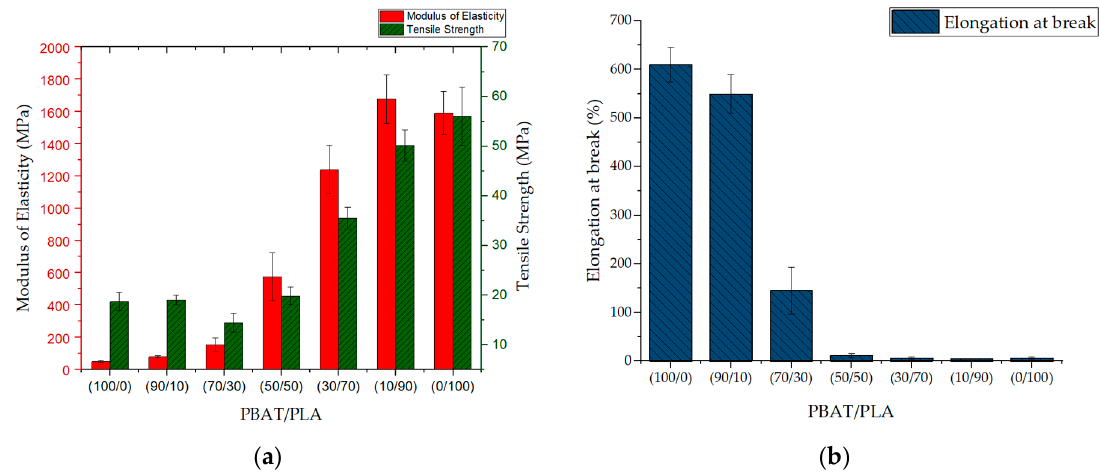
Figure 8. Tensile properties of pressed panels made of PBAT / PLA blends, pure PBAT and PLA. ( a ) modulus of elasticity and tensile strength, ( b ) elongation at break.